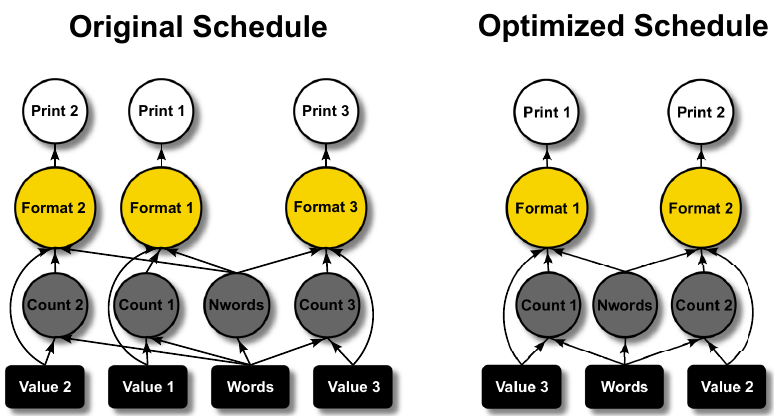
Figure 7. Typical task graph generated and optimized by DASK